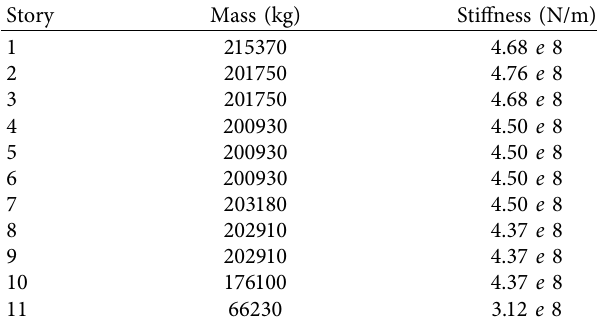
Table 1: Mass and stiffness of each